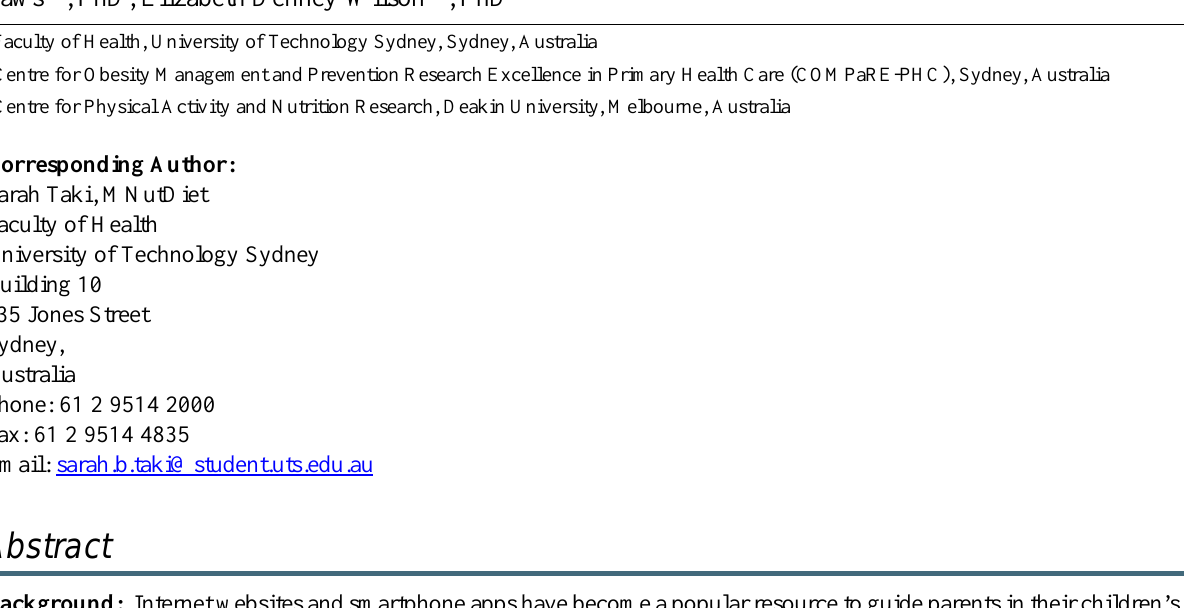
applications; Internet; infant feeding; health information; quality; suitability;